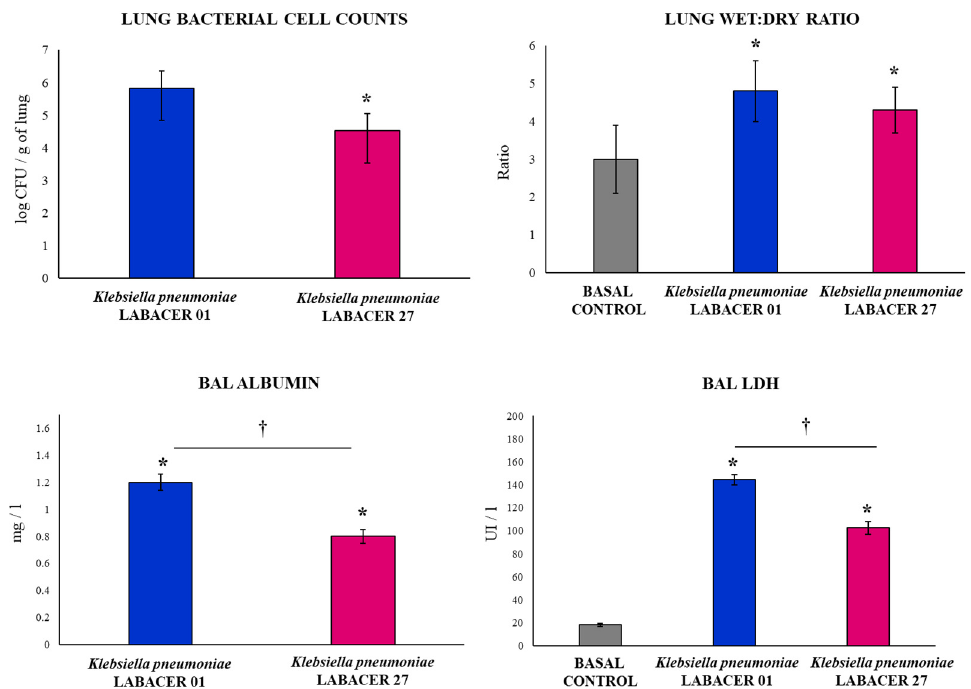
Figure 1. Lung colonization and damage induced by KPC-2-producing hypermucoviscous ST25 strains of Klebsiella pneumoniae . Immunocompetent adult BALB/c mice (six weeks) were challenged nasally with K. pneumoniae LABACER 01 or LABACER 27. Two days after challenge, the bacterial cell counts in lung homogenates, the lung wet:dry ratio, lactate dehydrogenase (LDH) enzyme activity, and the albumin concentration were determined in broncho-alveolar lavage (BAL) samples. Results represent data from three independent experiments. Asterisks (*) indicate significant differences from the uninfected control group (basal control), p < 0.05. The crosses (†) indicate significant differences between the indicated groups, p < 0.05. Basal levels of BAL albumin were below the detection limit.